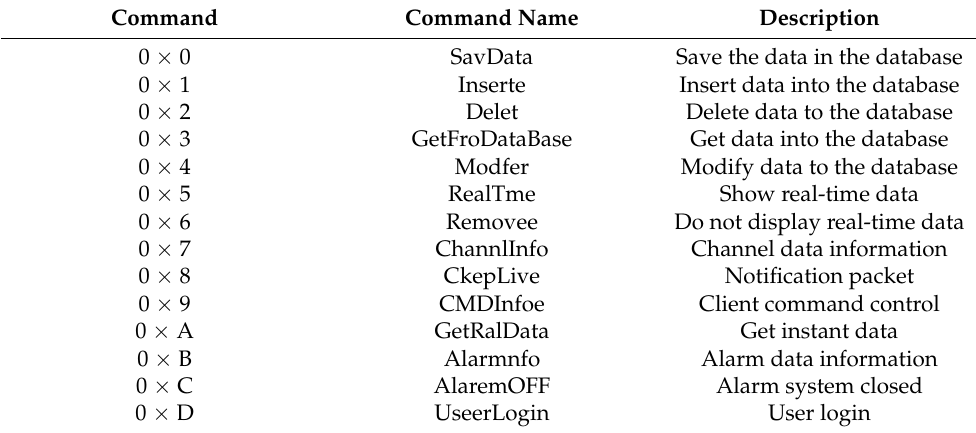
Table 3. Command type.